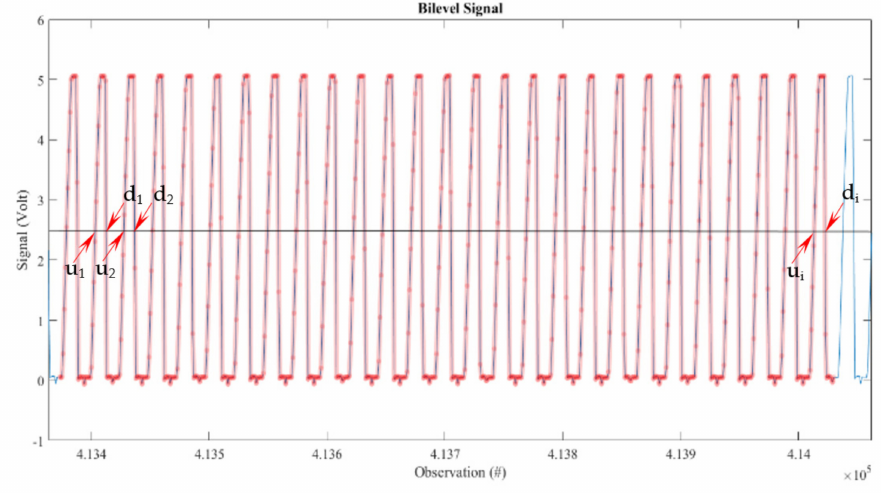
Figure 11. Standard encoder voltage output vs.